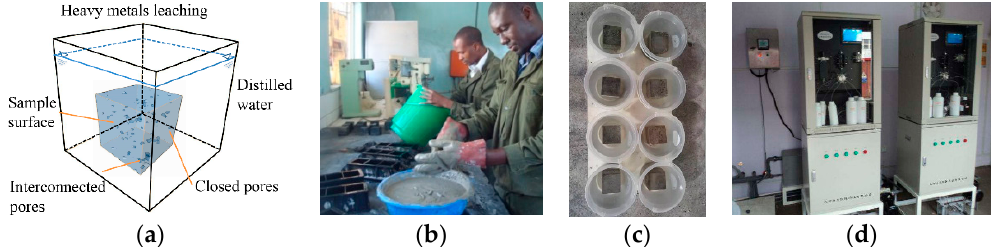
Figure 1. Cemented paste backfill (CPB ) block leaching and leachate ion testing. ( a ) EA NEN 2004 tank test scheme. ( b ) CPB block preparation. ( c ) Blocks leaching. ( d ) Water quality heavy metal analyzer.